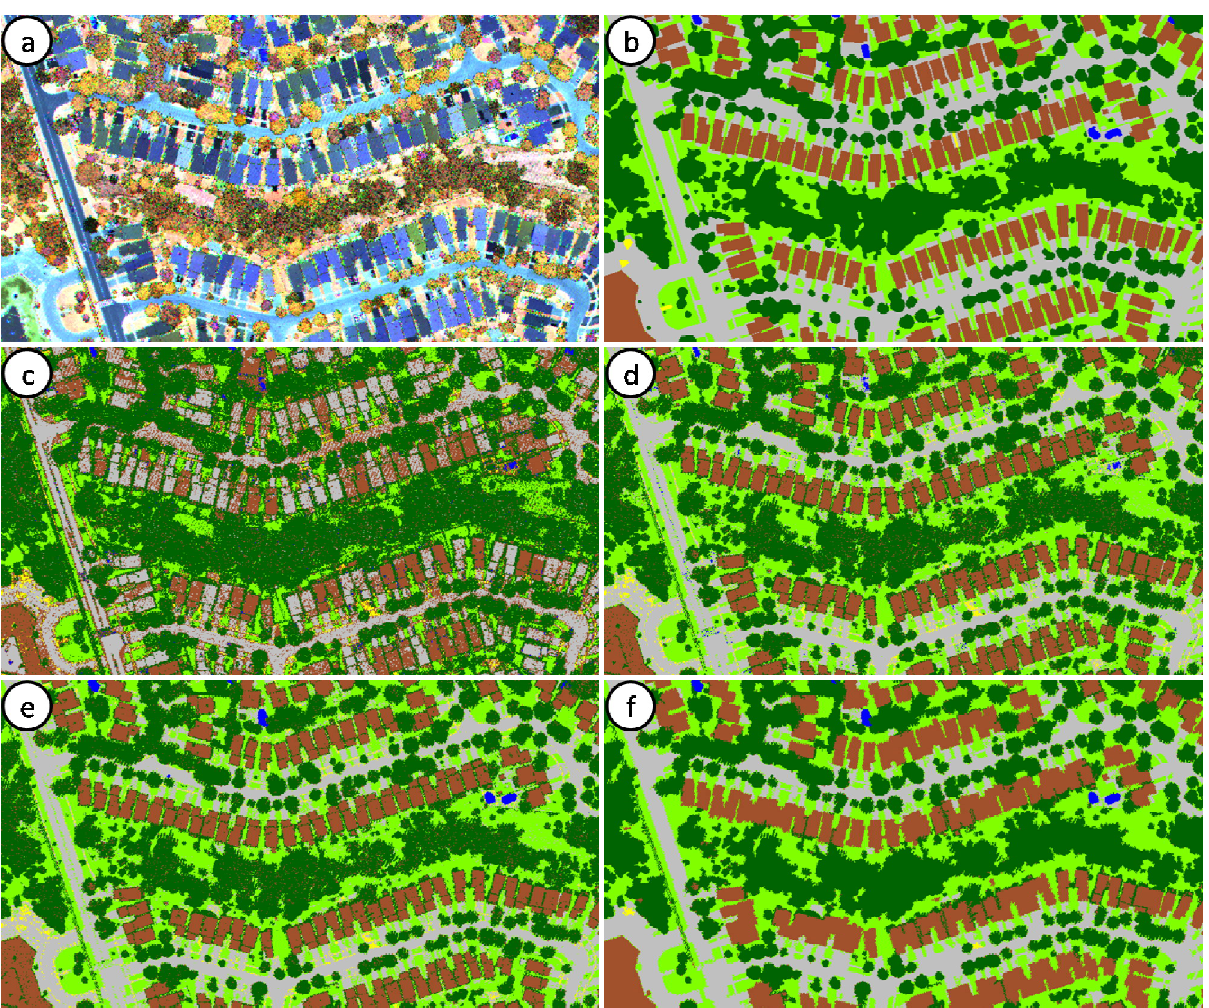
Figure 5. a) colour composition R-IR, G-SWIR, B-G, b) reference mask, c) Approach 1ab, d) Approach 2ab , e) Approach 3ab , f) Approach 4ab m+f ; “water” – blue, “sand/gravel” – yellow, “low vegetation” – green, “asphalt/concrete” – grey, “buildings”